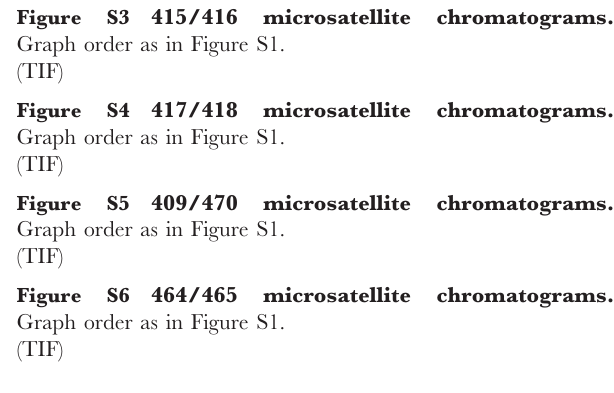
Figure S3 415/416 microsatellite chromatograms. Graph order as in Figure S1. (TIF) Figure S4 417/418 microsatellite chromatograms. Graph order as in Figure S1. (TIF) Figure S5 409/470 microsatellite chromatograms. Graph order as in Figure S1. (TIF) Figure S6 464/465 microsatellite chromatograms. Graph order as in Figure S1. (TIF)